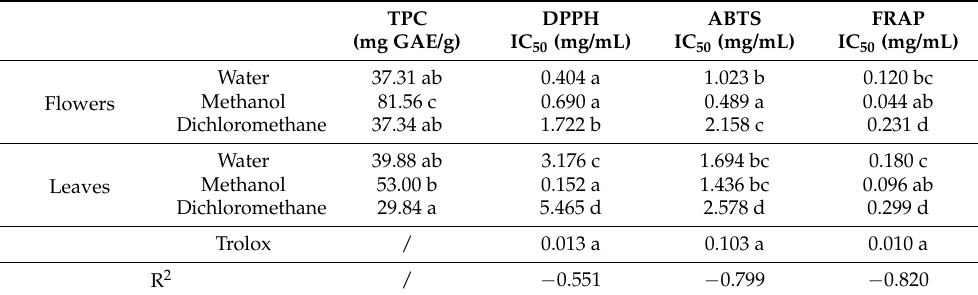
Table 1. The total phenolic content (TPC) and antioxidative activity, measured by 1,1-diphenyl-2- picrylhydrazyl (DPPH), 2,2 (cid:48) -azino-bis(3-ethylbenzothiazoline-6-sulphonic acid (ABTS) and ferric reducing antioxidant power (FRAP) assays, of French marigold flowers and leaves extracts. Correlation between antioxidative potential and TPC was presented as Pearson’s coefficient (R 2 ) for each assay.